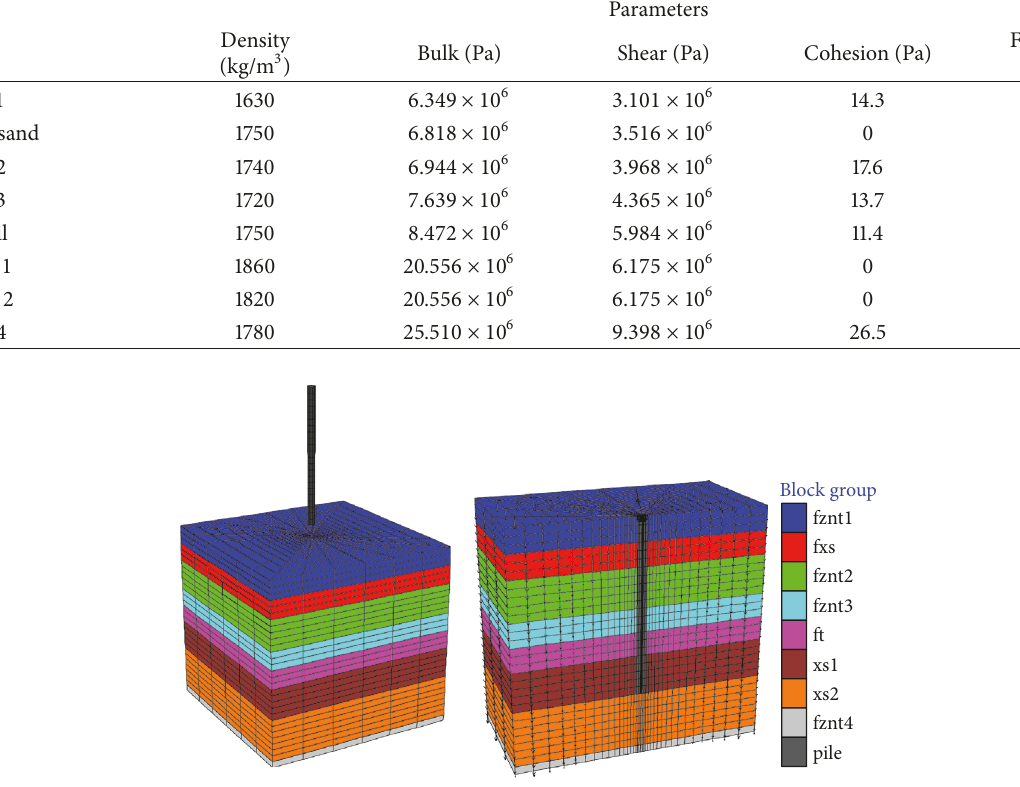
Figure 1: Simulation model of energy